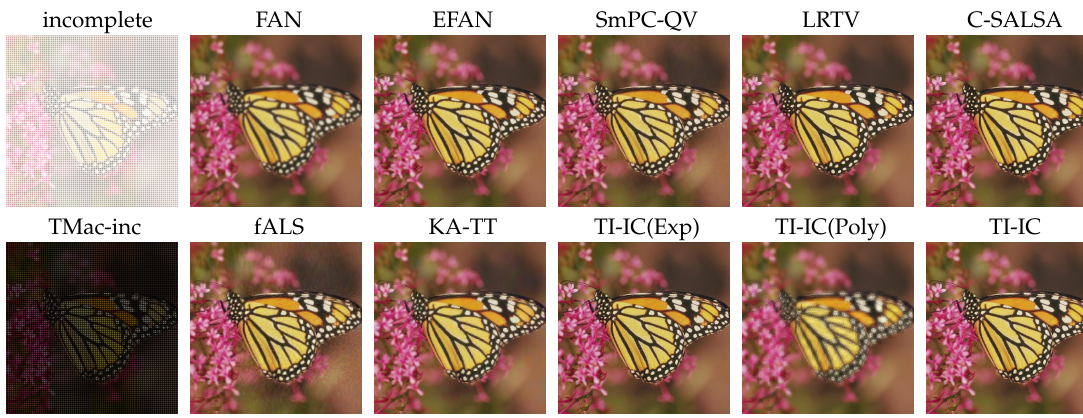
Figure 5. Test D: resolution up-scaling for the image